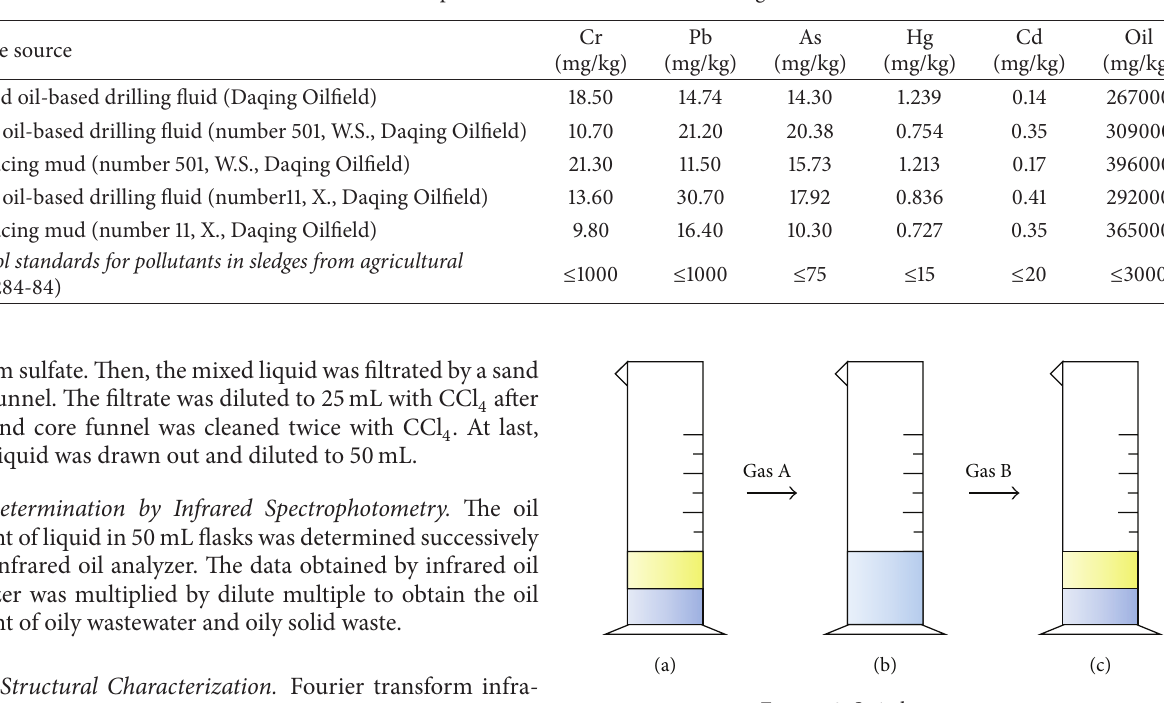
Figure 2: Switch